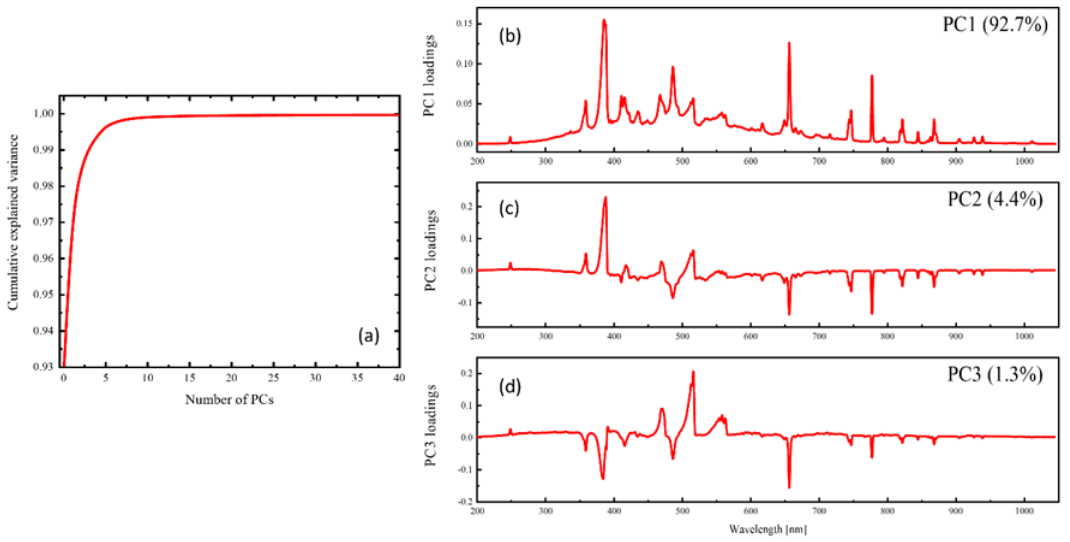
Figure 4. ( a ) Cumulative explained variance, loadings plots for ( b ) PC1, ( c ) PC2, and ( d ) PC3.